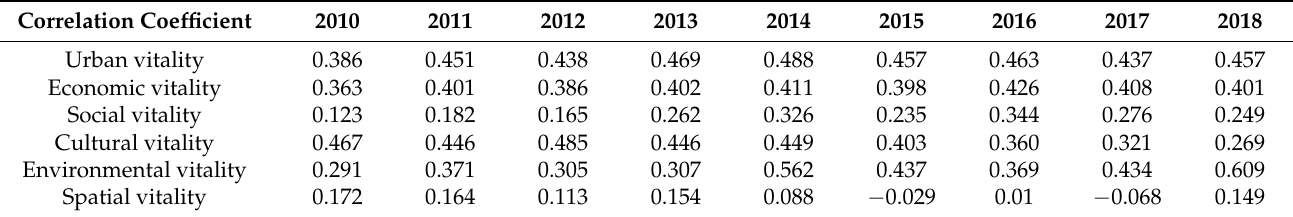
Table 6. The correlation coefficient between urban shrinkage and urban